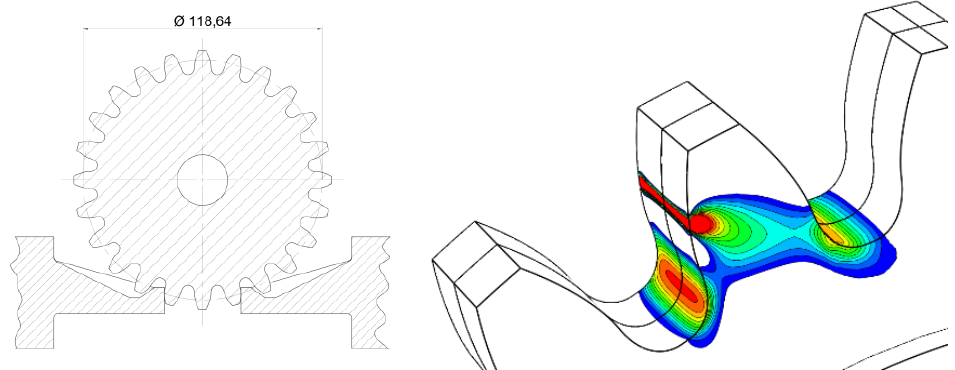
Figure 2. Scheme of the gear/anvils contact; dimensions are in mm; FEM analysis of the loaded tooth during Single Tooth Bending Fatigue (STBF) tests .